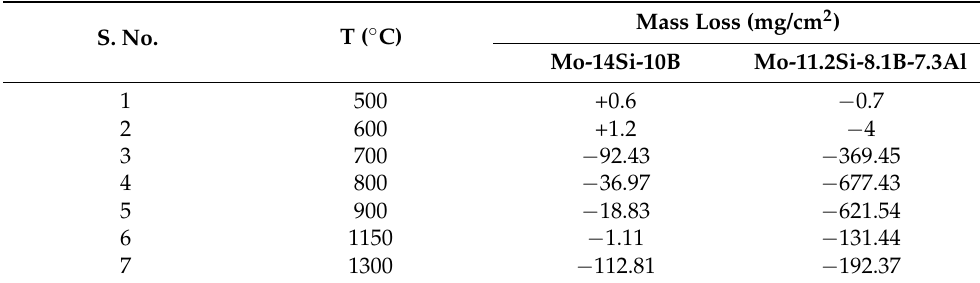
Table 2. Mass loss of both alloys after oxidation at different temperatures for 24 h. Reproduced with permission [64,65]. Copyright 2006 Elsevier and 2007 Elsevier. Mass Loss (mg/cm 2 ) S. No. T ( ◦ C) Mo-14Si-10B